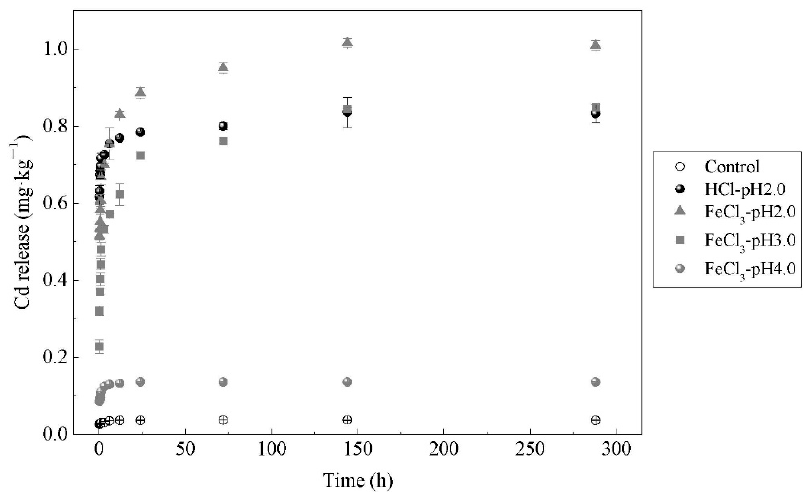
Figure 1. Kinetics for the Cd extracted from contaminated paddy soil by FeCl 3 .